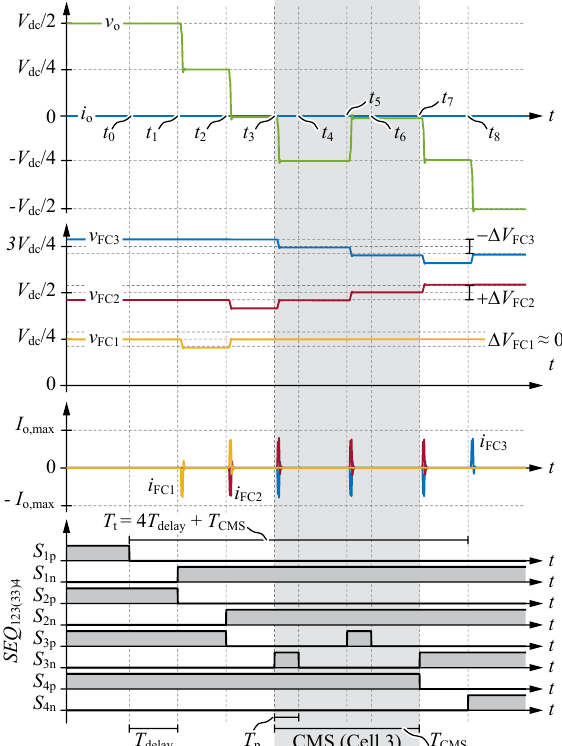
Figure 5. Simulation results for the 5L-FCC in configuration 1 (cid:13) with zero output current during the Q2L transition with negative slope of v o : Note the single cell multiple switching event of cell 3. A delay T delay and a pulse time T p = 0.5 T delay are used. Note that the same T delay , however a different time base are used compared to Figure